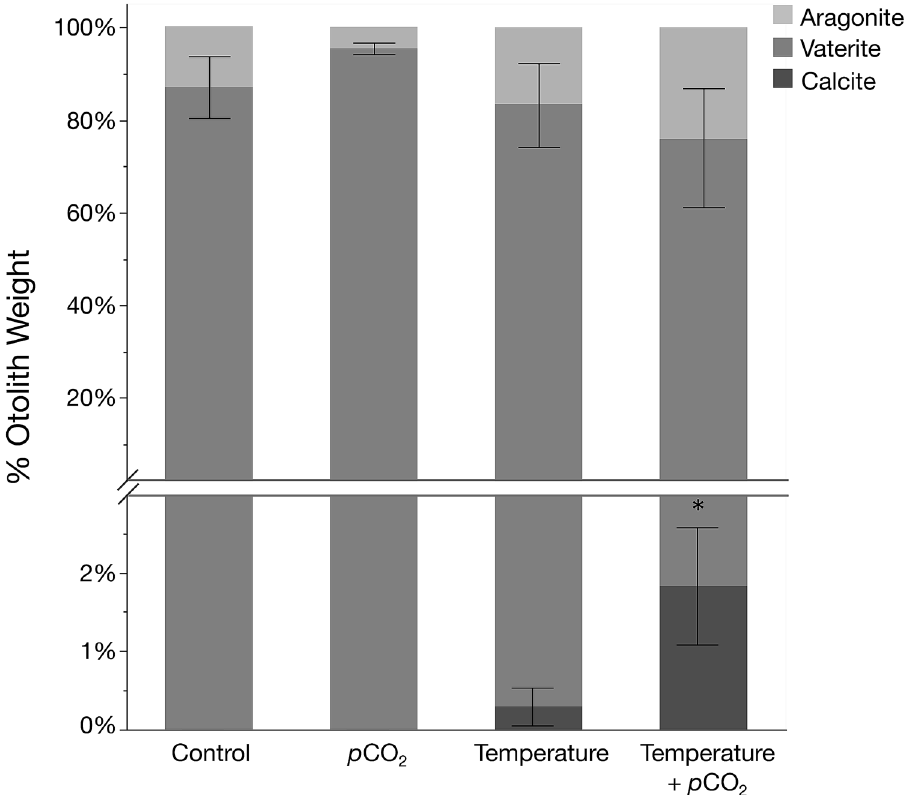
Figure 4. Mean (± s.e.m., n = 8 otoliths) percent polymorph composition (i.e., aragonite, vaterite, calcite) by weight of sagittal otoliths collected from age-0 Lake Sturgeon, Acipenser fulvescens , within each experimental treatment (i.e., control [15 °C, 1000 μatm p CO 2 ], p CO 2 [15 °C, 2500 μatm p CO 2 ], temperature [22 °C, 1000 μatm p CO 2 ], temperature + p CO 2 [22 °C, 2500 μatm p CO 2 ]). Note the break in y-axis corresponds to a change in scale. *Indicates calcite composition is significantly different among experimental treatments where calcite was present (ANOVA, <